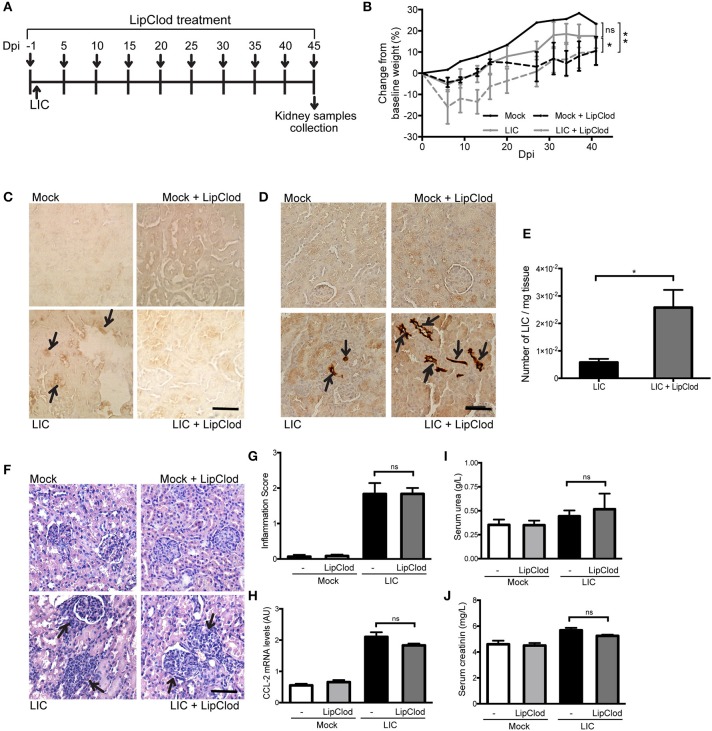
Depletion of macrophages resulted in an increased chronic renal bacterial burden and similar chronic interstitial nephritis. (A) Treatment scheme for intraperitoneal depletion and infection in Mock, Mock + LipClod, LIC and LIC + LipClod groups of C57BL/6J mice. (B) Percentage of body weight change in all groups of mice during the 45 days post-infection (dpi) showing that the LIC + LipClod group had significantly reduced weight gain. Immunostaining with an antibody against F4/80+ cells (macrophages) (C) confirming macrophage depletion or with anti-LipL32 (the major Leptospira interrogans antigen) (D) in kidney sections of all experimental groups of mice at 45 dpi. Depletion of macrophages in LIC-infected mice resulted in more presence of leptospiral antigen. (E) Higher bacterial load in kidneys of LIC + LipClod group was detected compared to undepleted LIC group. β-actin was used as a housekeeping control. (F–H) Representative haematoxylin-eosin staining of kidney sections. An inflammation score was established by a pathologist and CCL-2 mRNA was quantified by qRT-PCR as a molecular marker of inflammation; β-actin was used as a housekeeping control. Similar chronic inflammation was observed among experimental groups. (I,J) Normal urea and creatinine levels in serum samples from all experimental groups were detected and assayed as a measure of renal functions at 45 dpi. In all cases, data represent assays of two independent experiments of groups of 6 animals, each. Bars indicate 50 microns; AU, arbitrary units; nsP > 0.05; *P < 0.05; **P < 0.01.